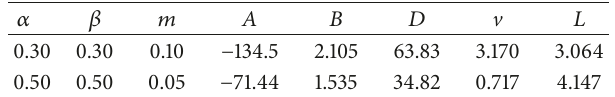
Table 2: Examples of values of 𝐴, 𝐵,𝐷, V , and 𝐿 for 𝑧 = 𝑧 1 case. 𝛼 𝛽 𝑚 𝐴 𝐵 𝐷 V